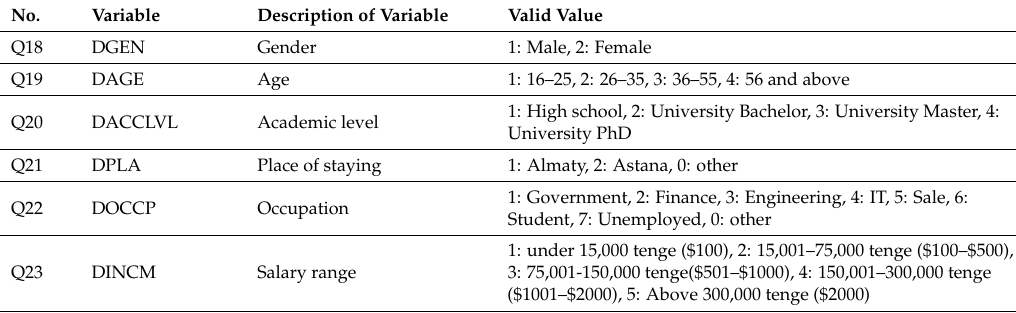
Table A3. Data coding (part 3).